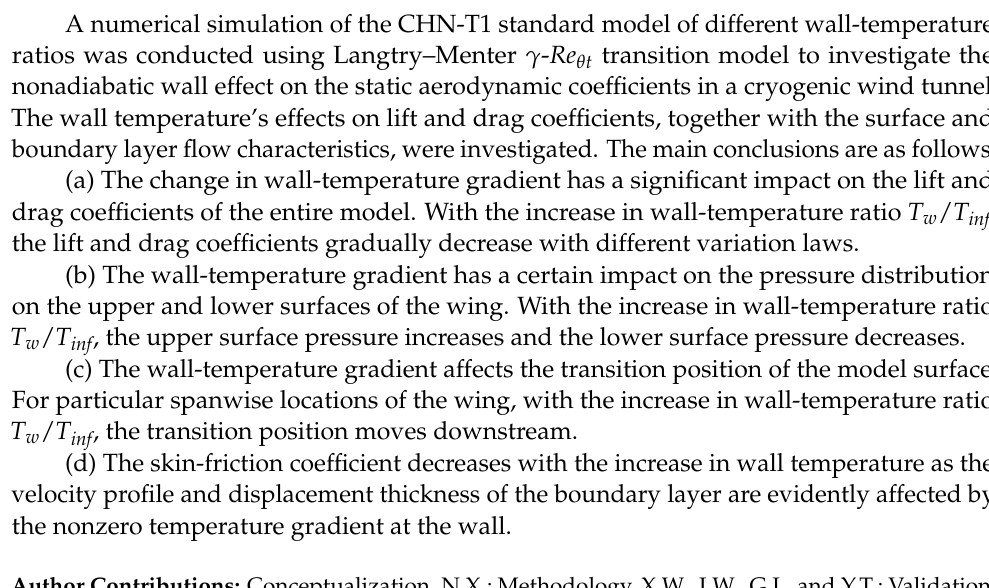
Figure 21. Turbulent kinetic energy distribution of different temperature gradient. ( a ) k v.s. y ; ( b ) k v.s. y/δ .